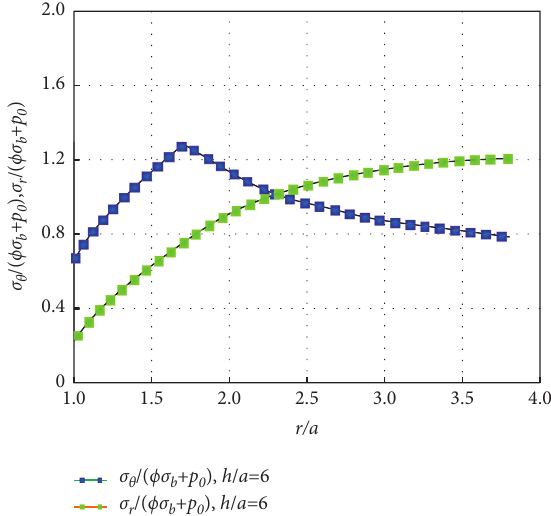
Figure 7: Stresses redistribution of surrounding rock after roadway